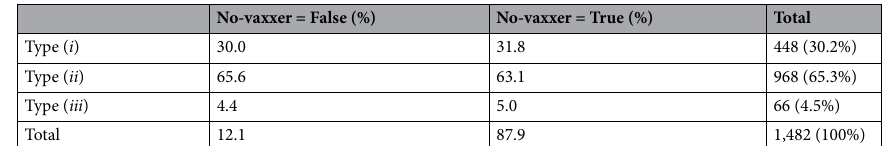
Table 4. Classification of respondents based on rationality and other-regarding preferences. Type ( i ) individuals play the Games consistently with the assumptions of homo economicus . Type ( ii ) are rational and have positive other-regarding preferences. Type ( iii ) are rational but have negative other-regarding preferences. The χ shows that the differences between vaxxers and no-vaxxers are not statistically significant ( p = 0.79 )